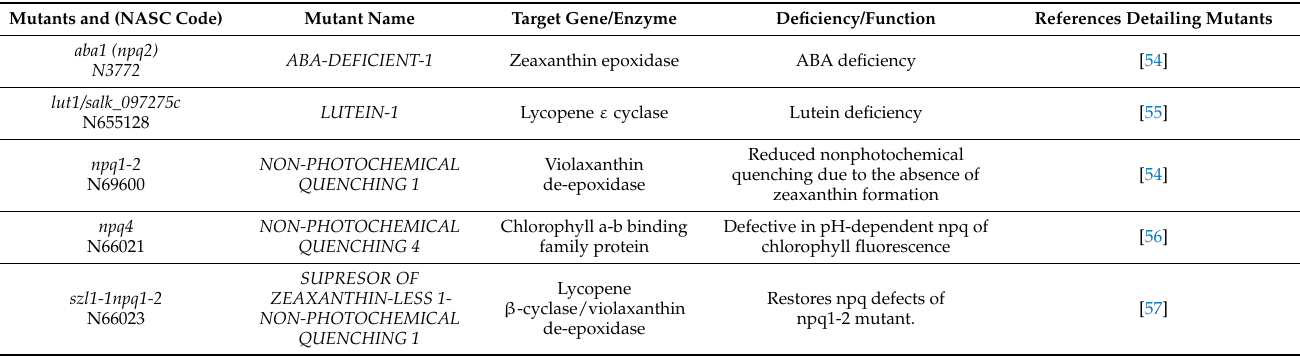
Table 1. List and details of carotenoid impaired genotypes used in this study. Key enzymes are as indicated in Figure